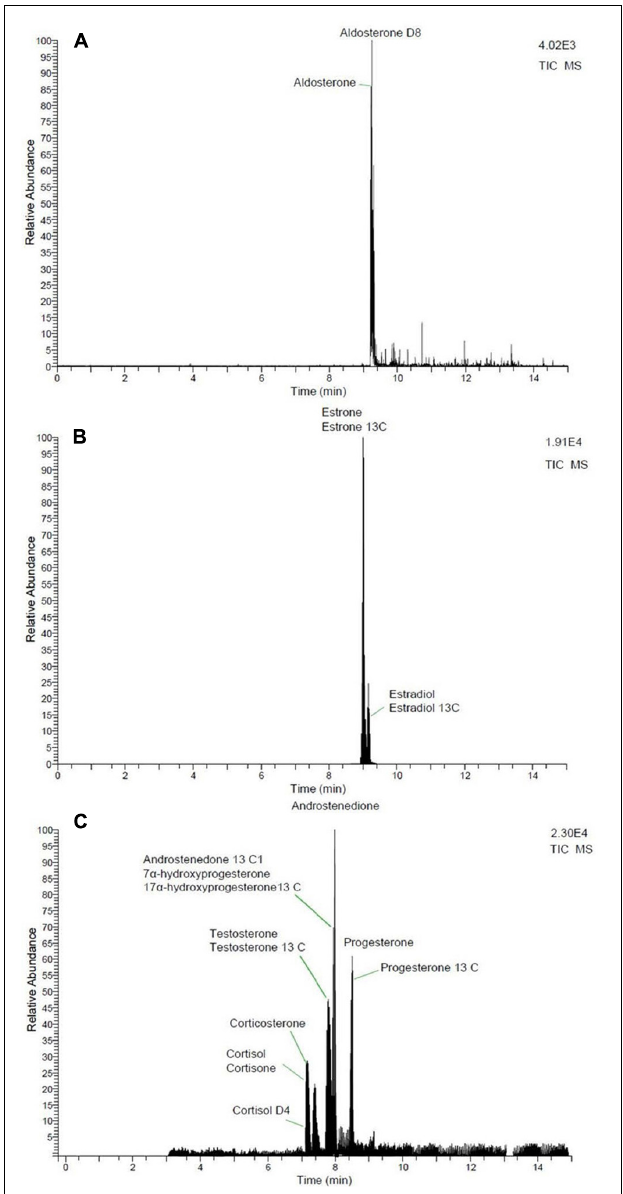
FIGURE 1 | Total ion chromatograms of hormones. (A) Aldosterone, (B) estrogens, and (C) corticosteroids, progestogens, and androgens.